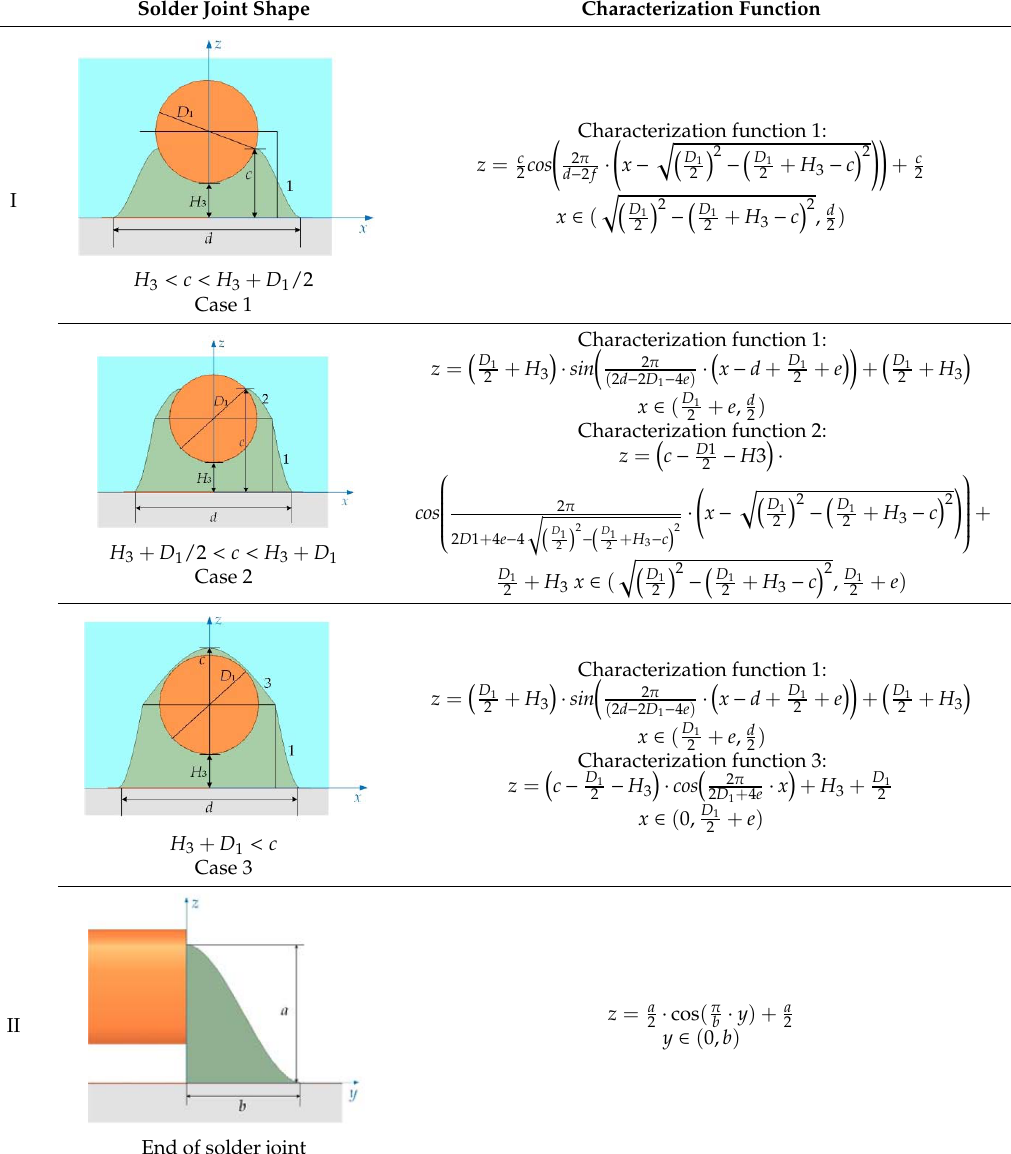
Table A2. Parameterized characterization.